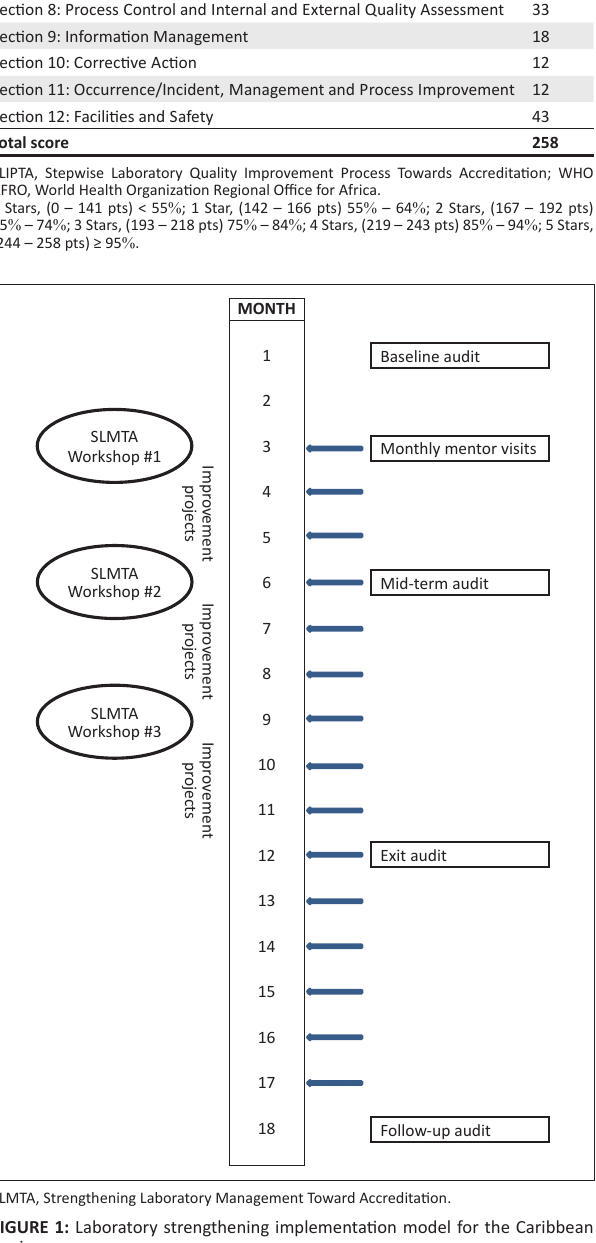
FIGURE 1: Laboratory strengthening implementation model for the Caribbean